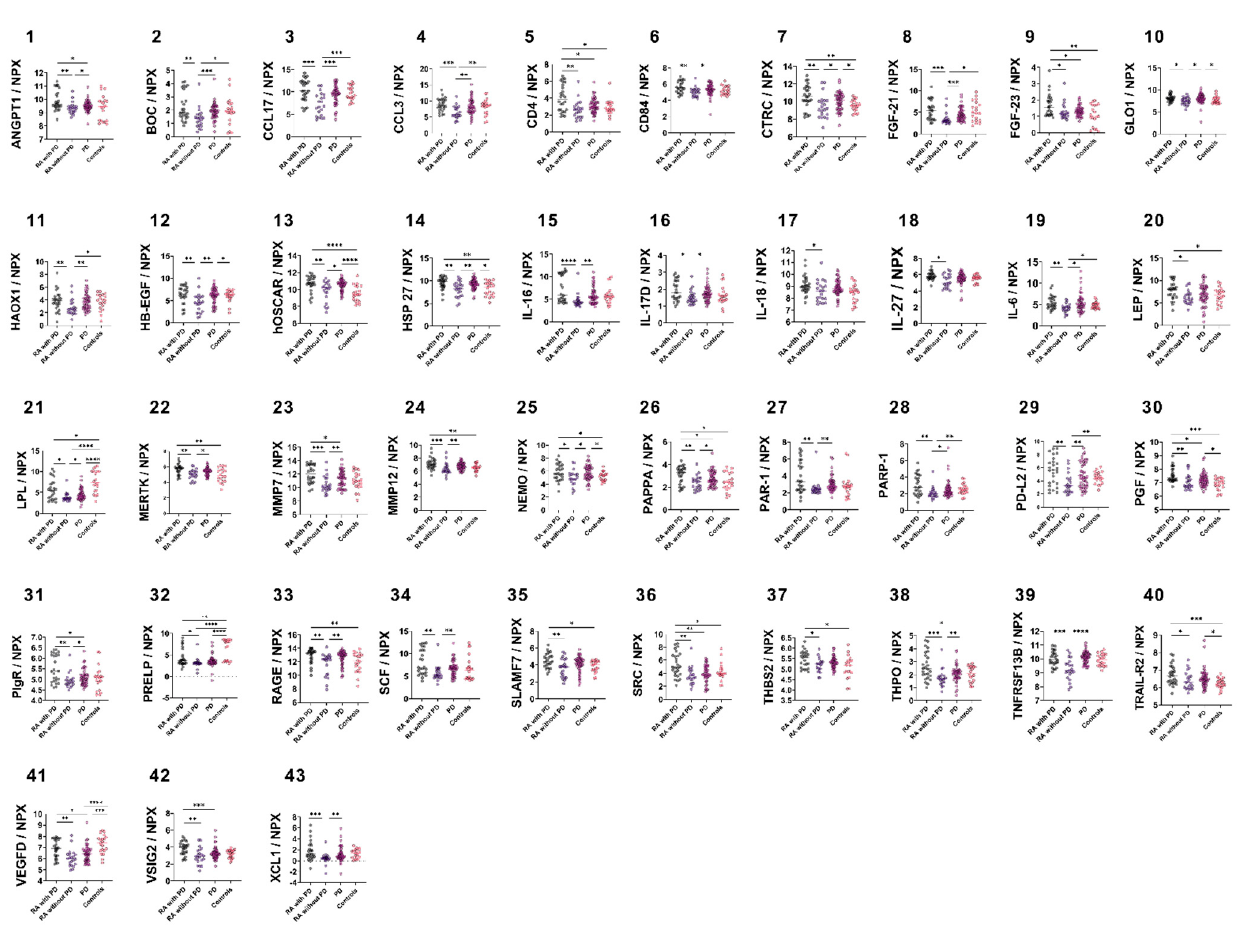
Figure 1. Group wise analyses for CVD-related biomarkers. Graphs 1–43 showing higher detection levels in RA with PD as compared to RA without PD. (1) ANGPT1, (2) BOC, (3) CCL17, (4) CCL3,